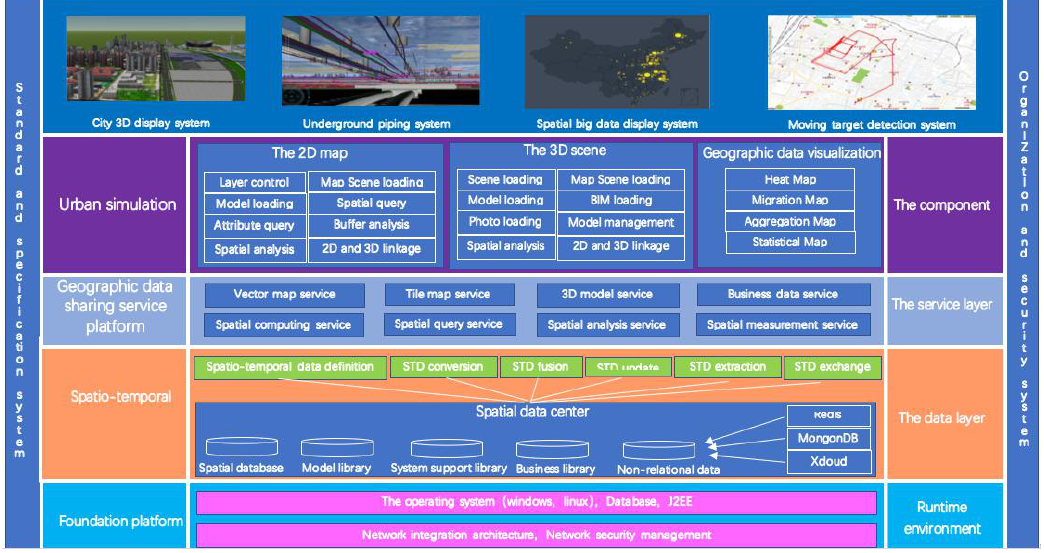
Fig.1 Overall architecture diagram of GIS development